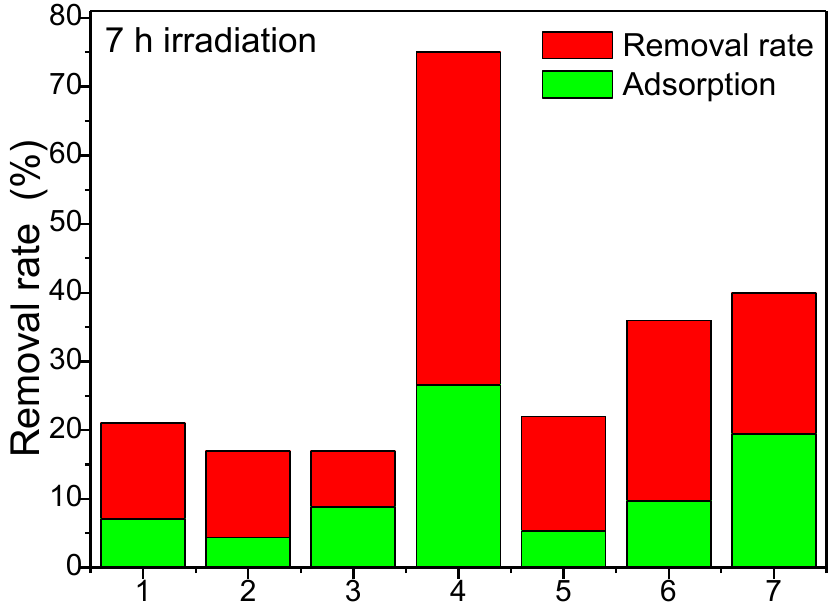
Figure 6. Removal rate of Zn 0.6 Co 0.4 Fe 2 O 4 @SiO 2 (1), Ni 0.1 Zn 0.5 Co 0.4 Fe 2 O 4 @SiO 2 (2), Ni 0.2 Zn 0.4 Co 0.4 Fe 2 O 4 @SiO 2 (3), Ni 0.3 Zn 0.3 Co 0.4 Fe 2 O 4 @SiO 2 (4), Ni 0.4 Zn 0.2 Co 0.4 Fe 2 O 4 @SiO 2 (5), Ni 0.5 Zn 0.1 Co 0.4 Fe 2 O 4 @SiO 2 (6) and Ni 0.6 Co 0.4 Fe 2 O 4 @SiO 2 (7) samples. The sample with similar Zn 2+ and Ni 2+ ions content (Ni 0.3 Zn 0.3 Co 0.4 Fe 2 O 4 @SiO 2 ) shows